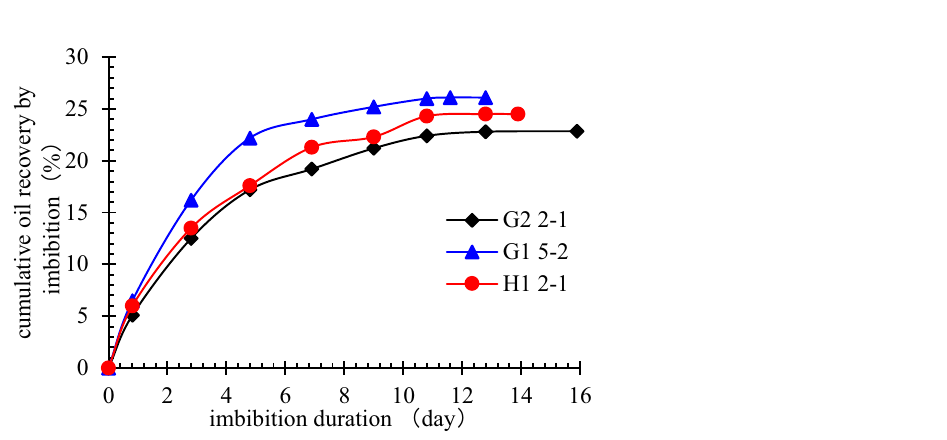
Figure 2. Cumulative imbibition recovery of different